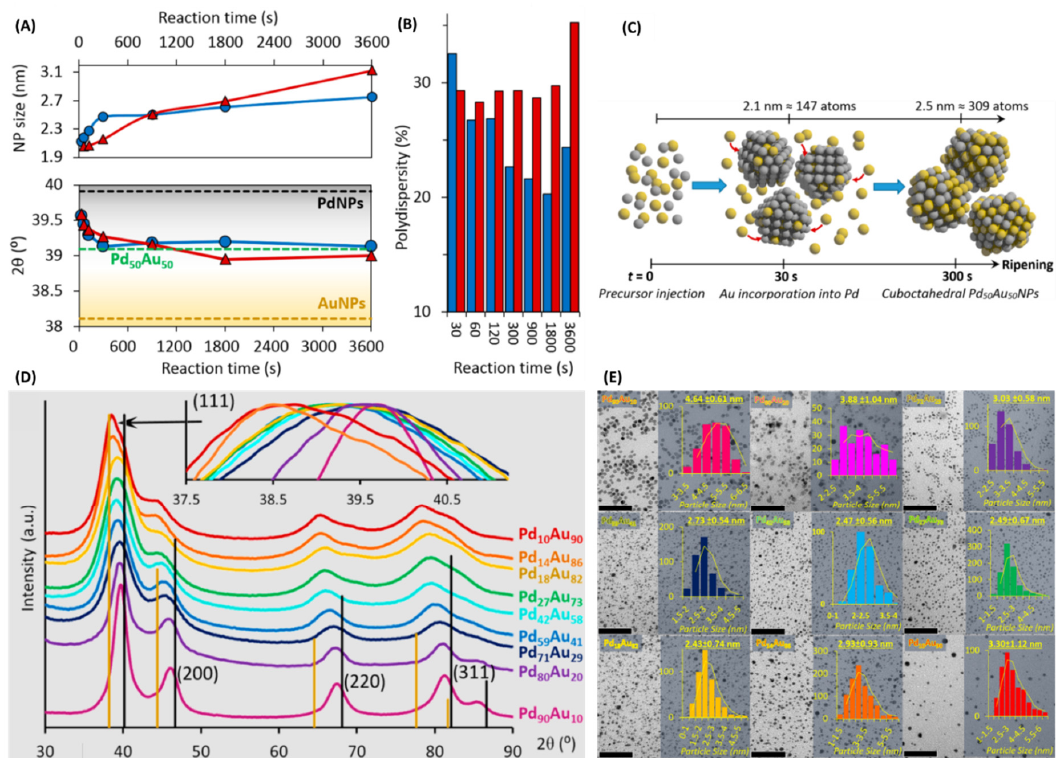
Figure 18. ( A ) Plot of average size vs. reaction time (min) shown in the top panel with the data for µwH shown in blue and CvH in red; <111> PXRD peak position vs. reaction time (min) is shown in the bottom panel using the same color scheme; ( B ) time-dependent polydispersity comparisons for the two heating methods, data for µwH and CvH are respectively shown in blue and red again; ( C ) time-dependent mechanism for the formation of Pd 50 Au 50 NPs under µwH; ( D ) PXRD patterns for Pd x Au 100- x NPs of different compositions, ICP-derived compositions are annotated on the right and the inset shows zoomed-in <111> region; ( E ) TEM images and size analysis of the various Pd x Au 100- x NP compositions synthesized using optimized conditions. Adapted with permission from the American Chemical Society. Copyright 2016 American Chemical Society.